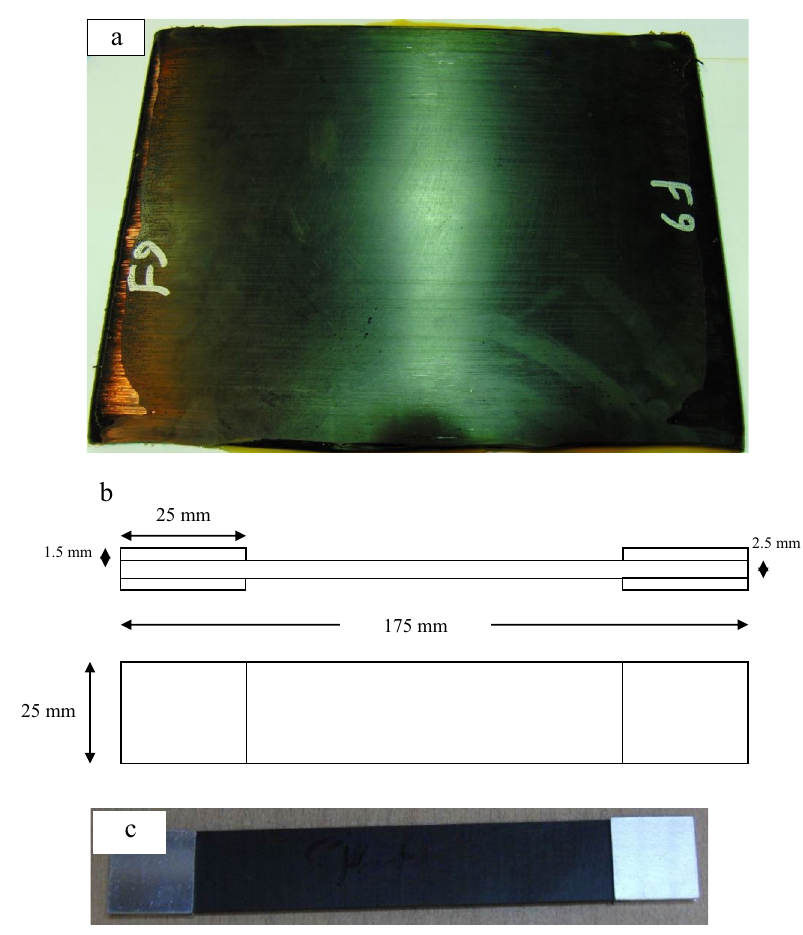
Fig. 3 The details of sample preparation for 90° tensile test ( a )Twelve-ply plate of com- posite, ( b ) schematic of UD90 sample with dimensions, and ( c ) UD90 tensile test